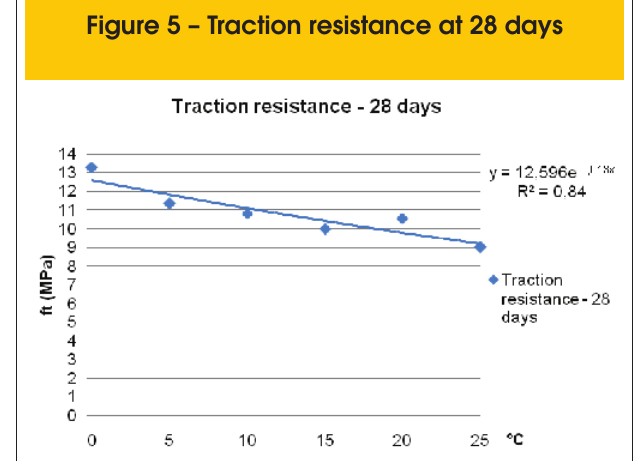
Figure 5 – Traction resistance at 28